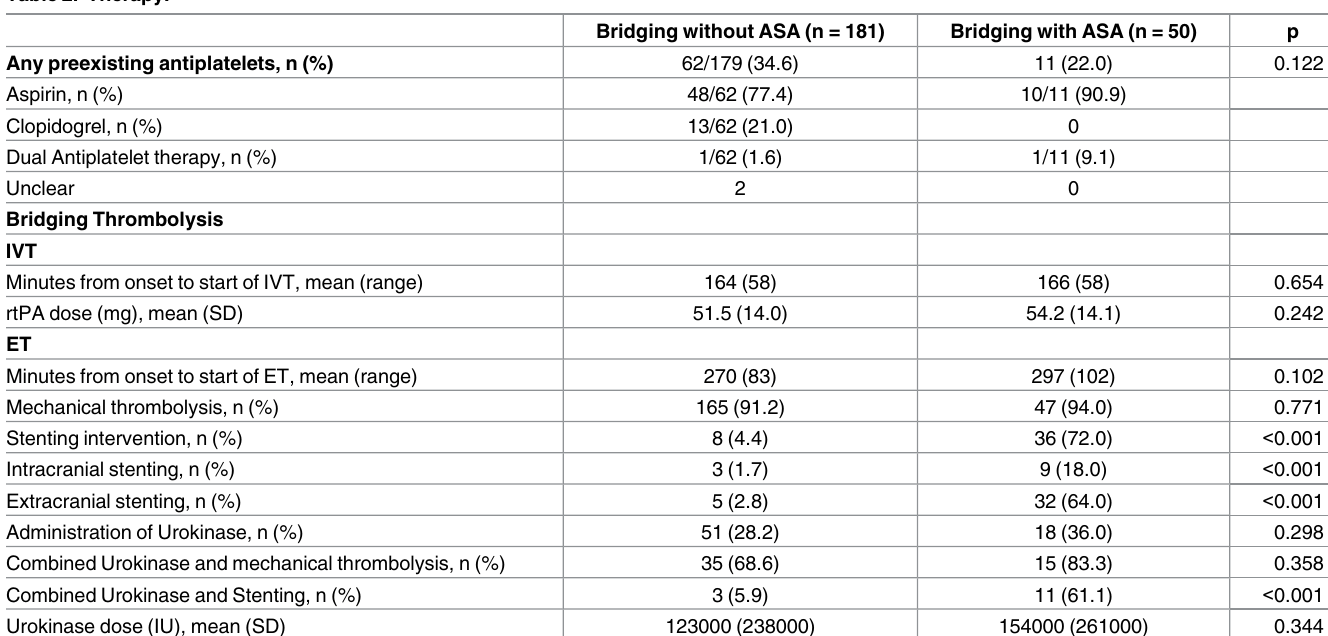
Table 2. Therapy.